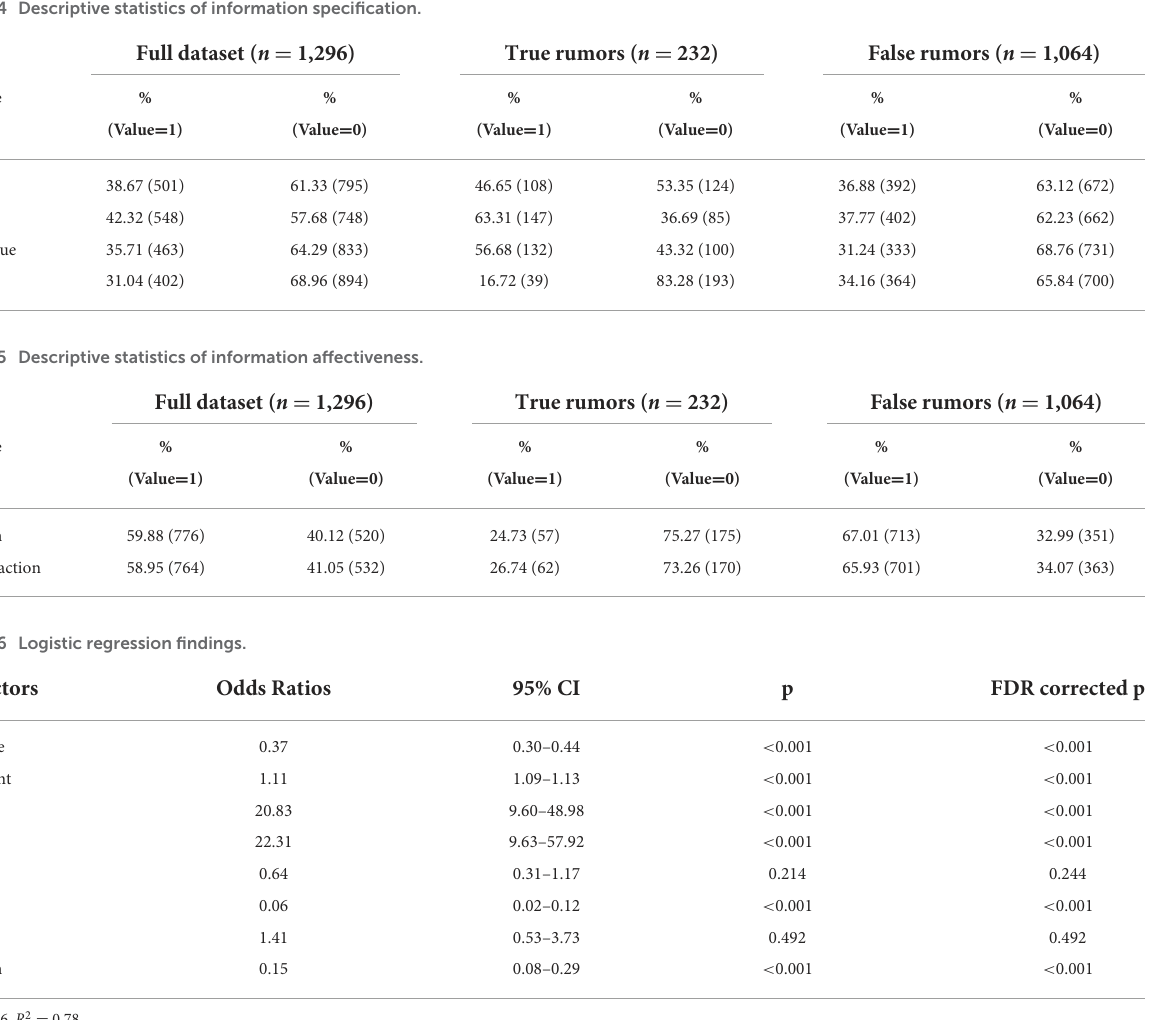
TABLE 4 Descriptive statistics of information specification.